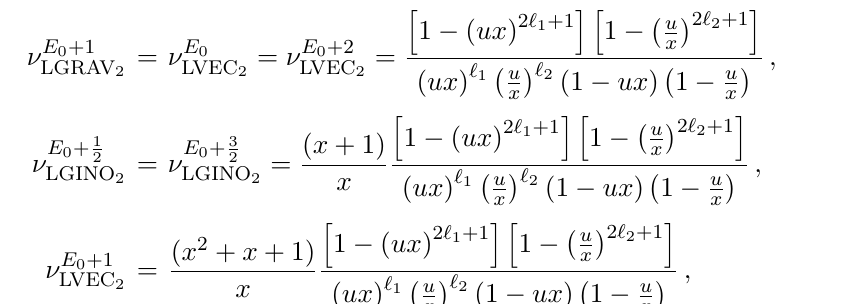
(cid:2) (cid:3) E 0 , 1 , 1 . 2 2